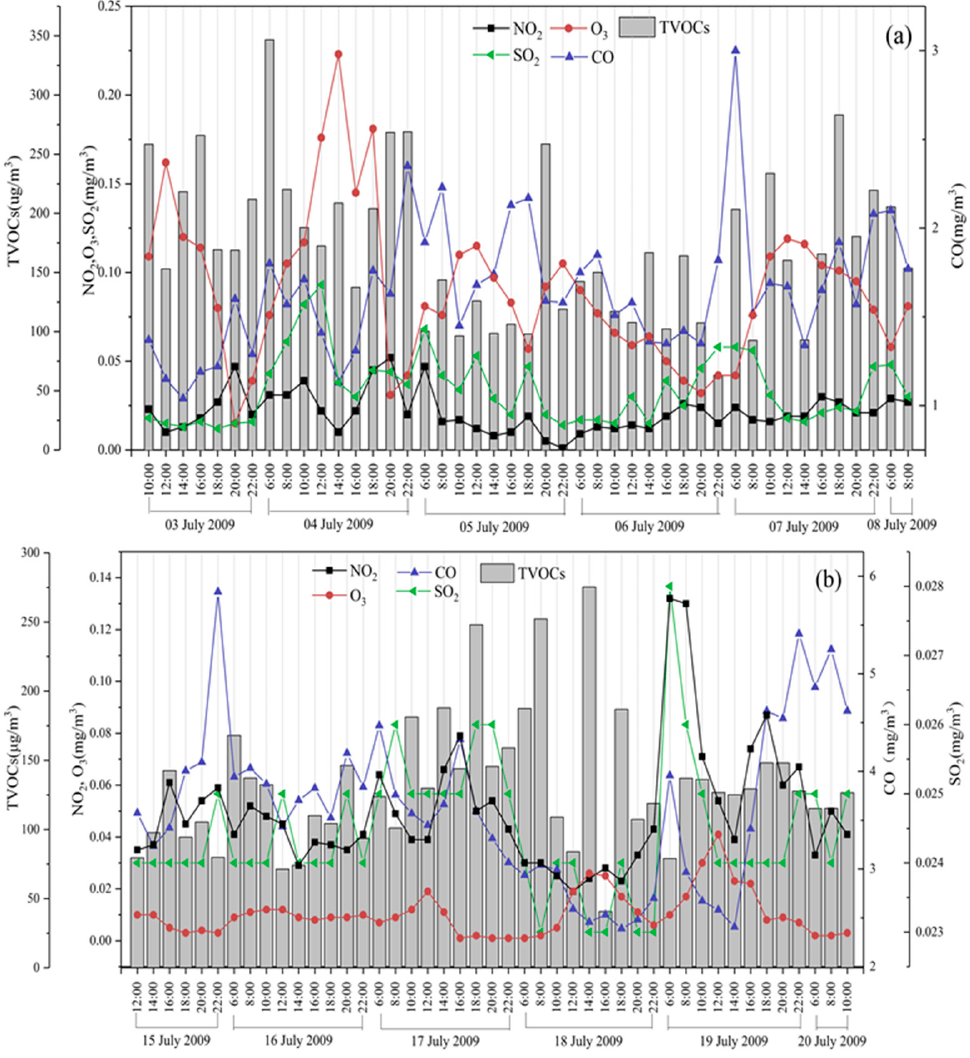
Figure 4. Time variation of measured NO 2 , O 3 , CO, SO 2 and TVOCs at Shenyang ( a ) and Fushun ( b ) during the campaign.